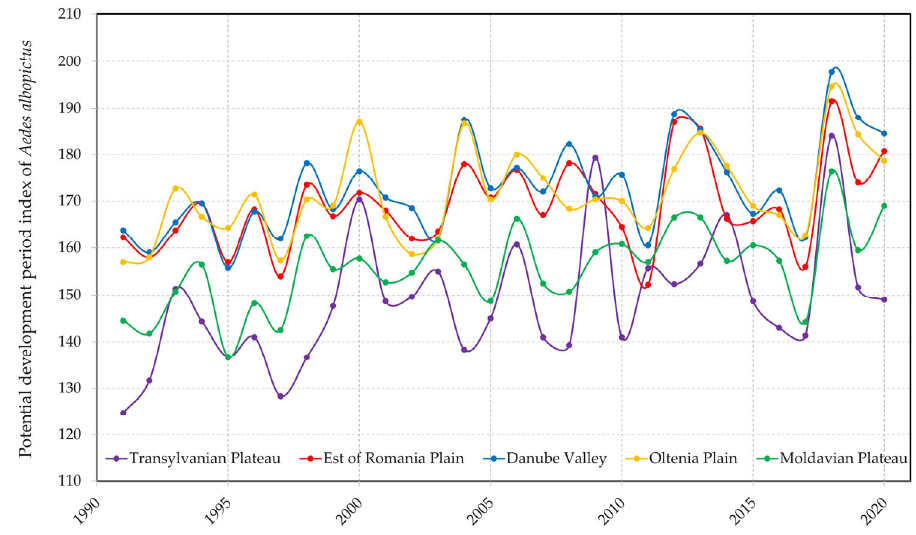
Figure 5. The development of the Ae. albopictus populations.